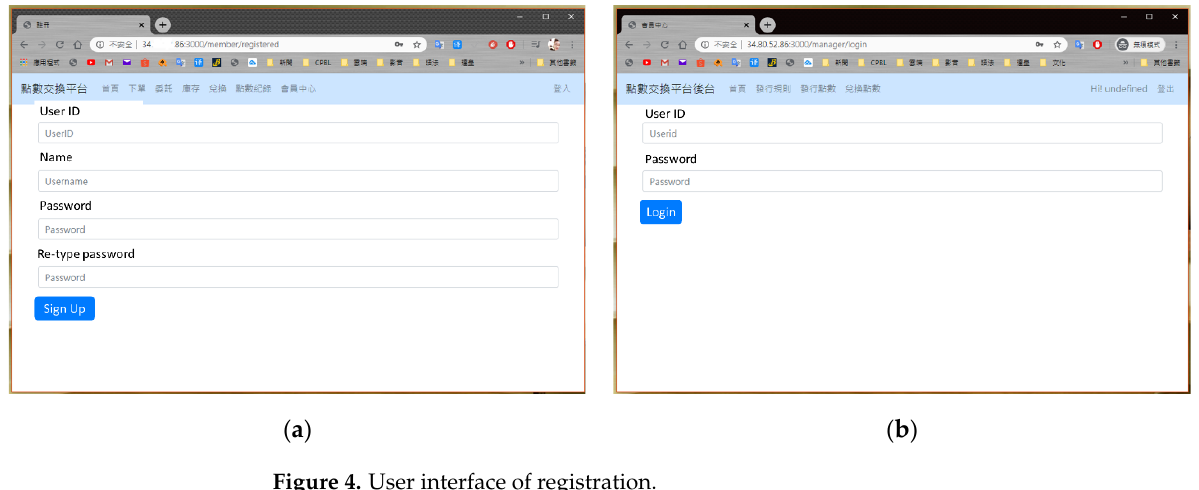
Figure 4. User interface of registration.